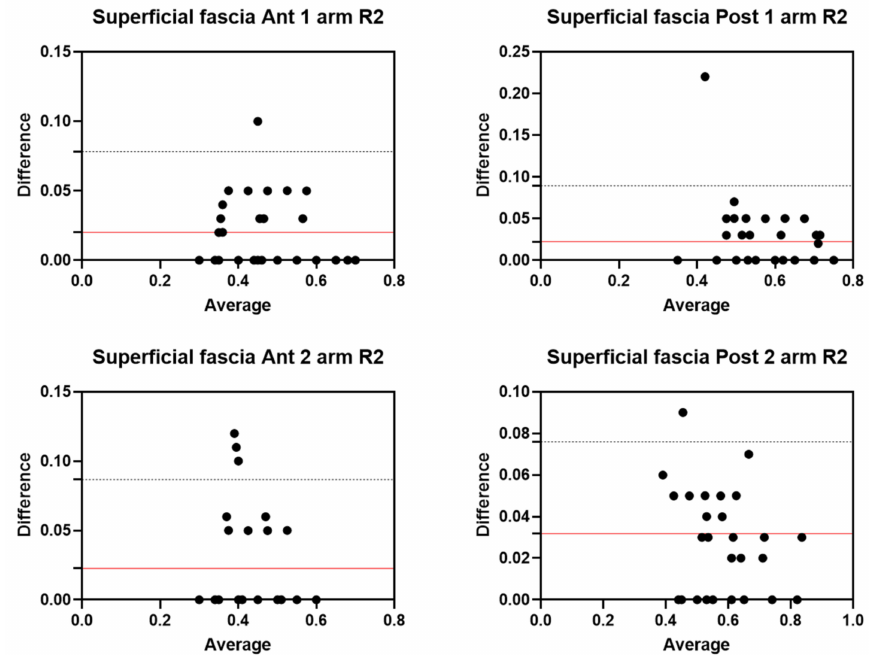
Figure 8. Bland–Altman plot comparing two sessions of Rater 2 (R2) measuring the US thickness of the superficial fascia of the arm for the different/levels. Red line = bias or mean difference; dashed lines: 95% limits of agreement (LoAs).